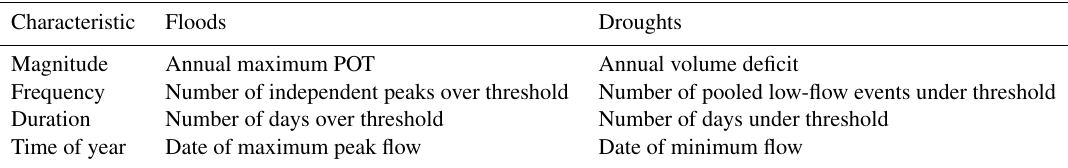
Figure 1. Selection and characterization in terms of frequency, magnitude, duration, and time of year of (a) floods (HF: high-flow event, AMAX: annual maximum POT) and (b) droughts (LF: low-flow event). Table 1. Summary of flood and drought